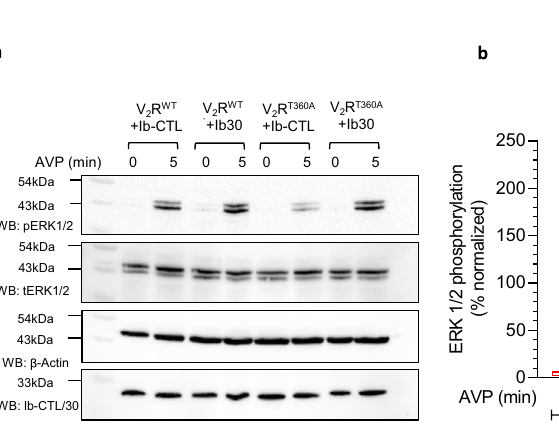
Fig.6|Ib30potentiatesendosomaltraf fi ckingof β arr1fortheV 2 R T360A mutant. a Schematic representation of BRET-based endosomal localization assay for β arr1.